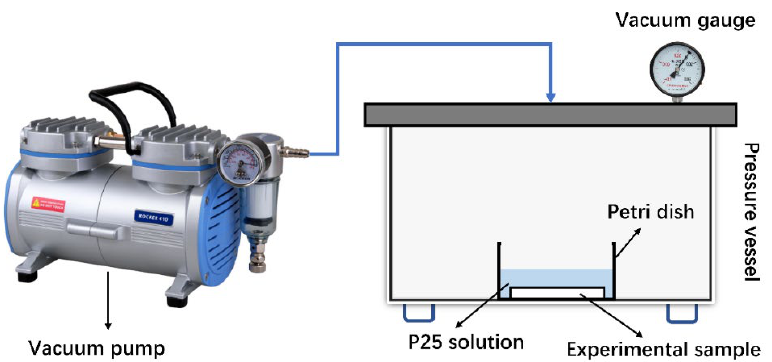
Figure 10. Device for TiO 2 photocatalyst loading on prepared matrix (P25- TiO 2 with an average particle size of 25 μ m).